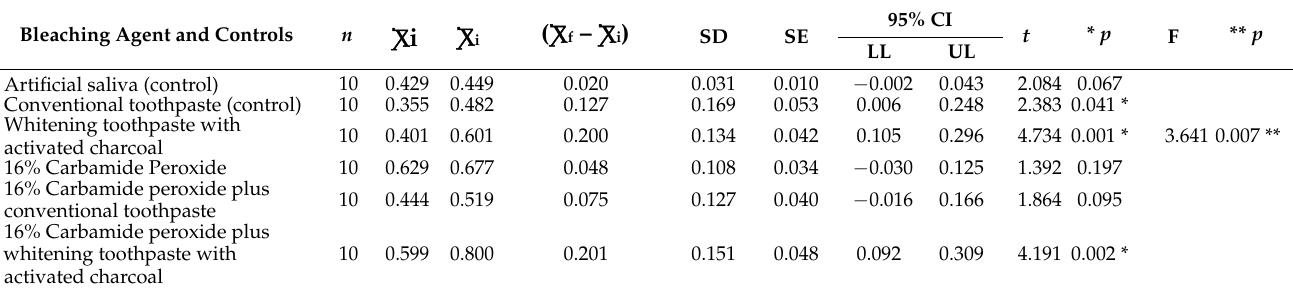
Table 1. Comparison of intragroup and intergroups variation in surface roughness ( µ m) when applying whitening agent, whitening toothpaste, and controls to bovine tooth enamel.